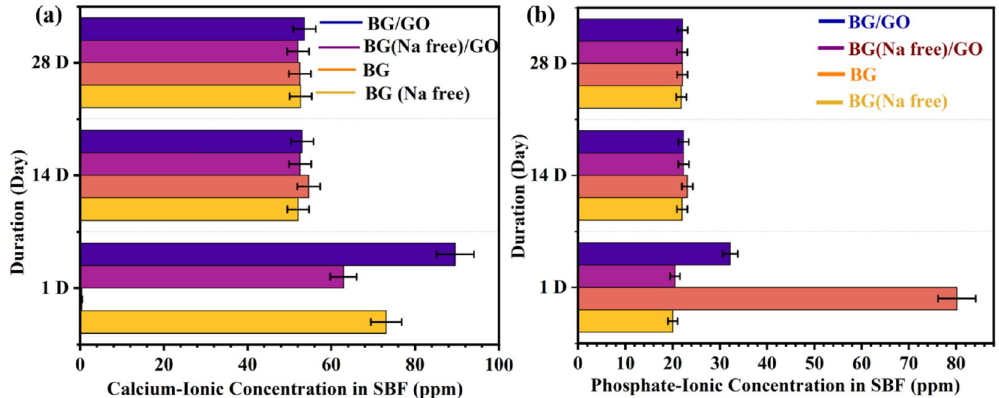
Figure 3. Determination of Ca and P concentration in SBF for different immersion days; ( a ) calcium ion concentration, ( b ) phosphate ion